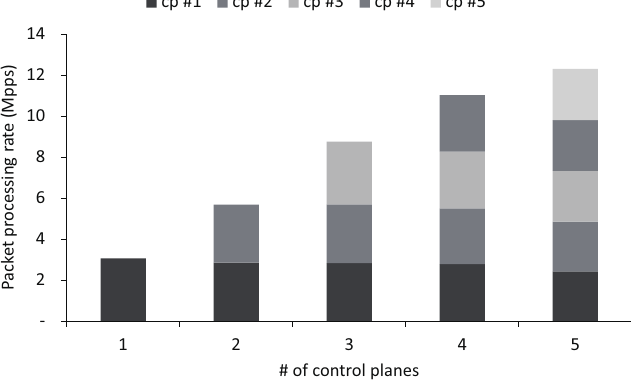
Figure 8. Aggregated performance with SE2 and SP2 achieves 38 Gbps when five control planes run concurrently. cp, control